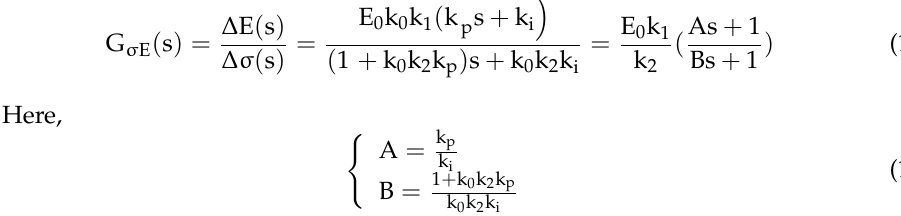
Figure 4. Small-signal model of a DFIG-VSG.